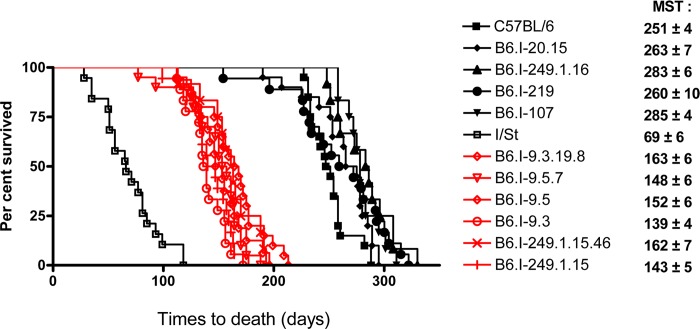
Survival curves of mice infected with M. tuberculosis.Survival of parental B6 and I/St and recombinant congenic mice (males) following aerosol challenge with ~500 CFU of M. tuberculosis H37Rv. Recombinant strains B6.I-9.3.19.8, B6.I-9.5.7, B6.I-9.5, B6.I-9.3, B6.I-249.1.15.46 and B6.I-249.1.15 all displayed similar (P > 0.1) intermediate mean survival time (MST) compared to hyper-susceptible I/St and relatively resistant B6 mice (P < 0.0001, log-rank test), which reflects the input of the intra-H2 QTL in susceptibility. All recombinant strains were tested in 3–10 independent experiments (total N = 20–70 animals). Summary of 3–5 experiments is displayed (Kaplan-Meier survival analysis).